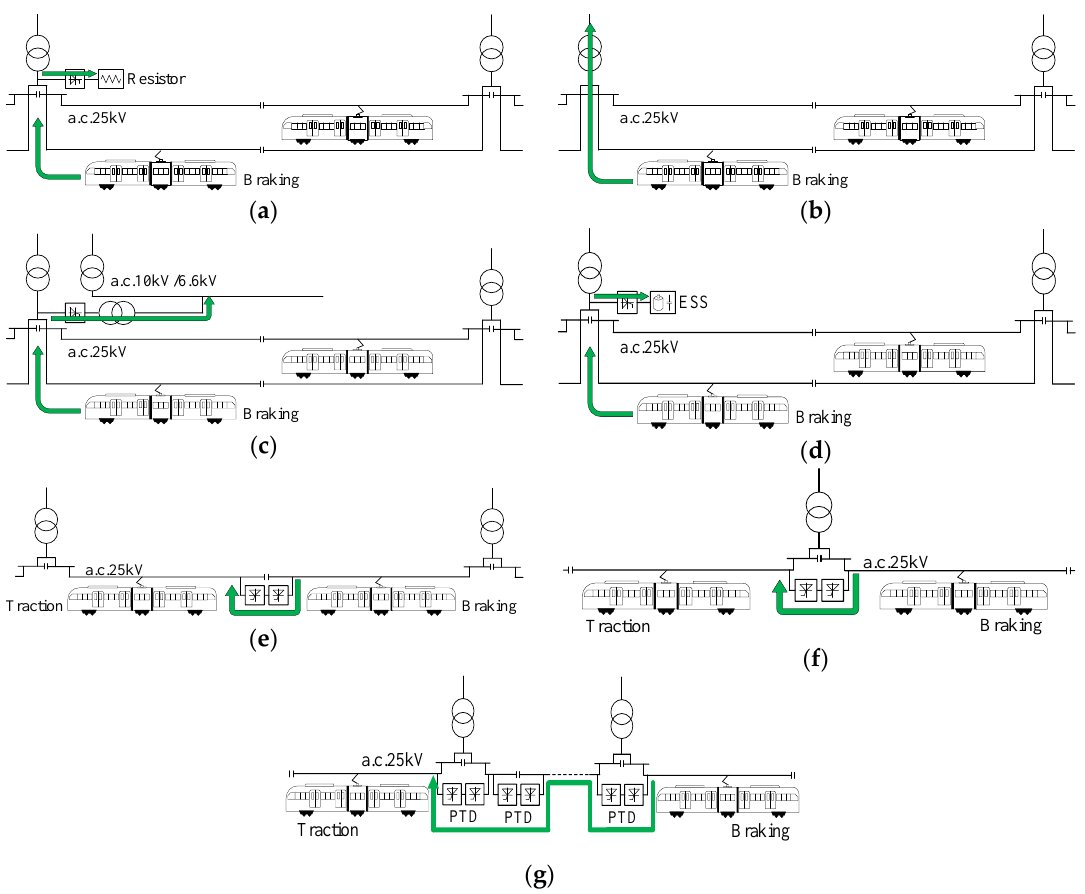
Figure 1. Regenerative braking energy (RBE) utilization schemes ( a ) regenerative resistance; ( b ) feeding into grid; ( c ) feeding into distribution grid; ( d ) storage energy with an energy storage system (ESS); ( e ) tie feeding in a section post (SP); ( f ) tie feeding in a traction substation (TS); and ( g ) smart electrical infrastructure.